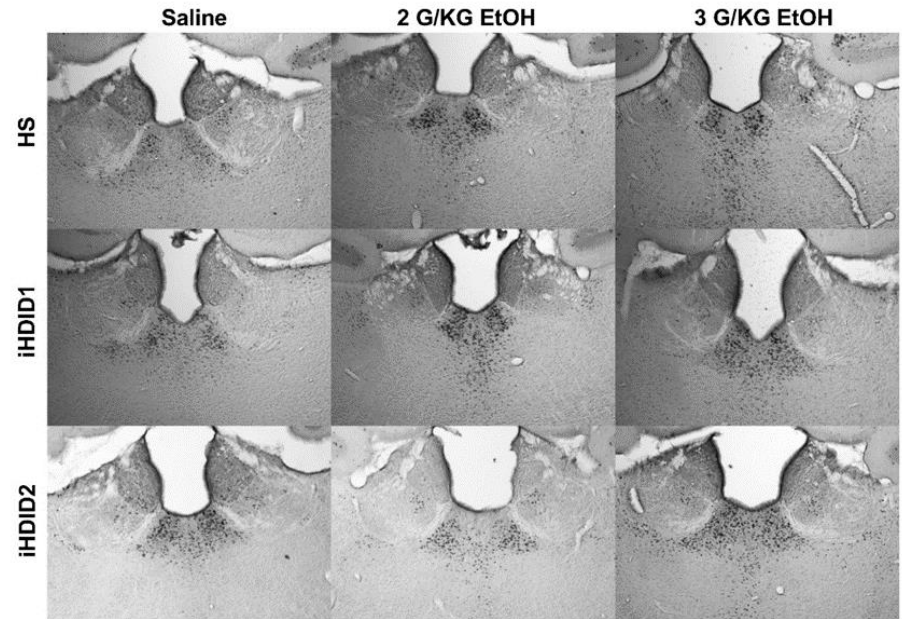
Figure 9. Lateral and Medial Habenula and Paraventricular Nucleus of the Thalamus. Representative images of c-Fos expression in the LHb, MHb, and PVT across genotype and treatment